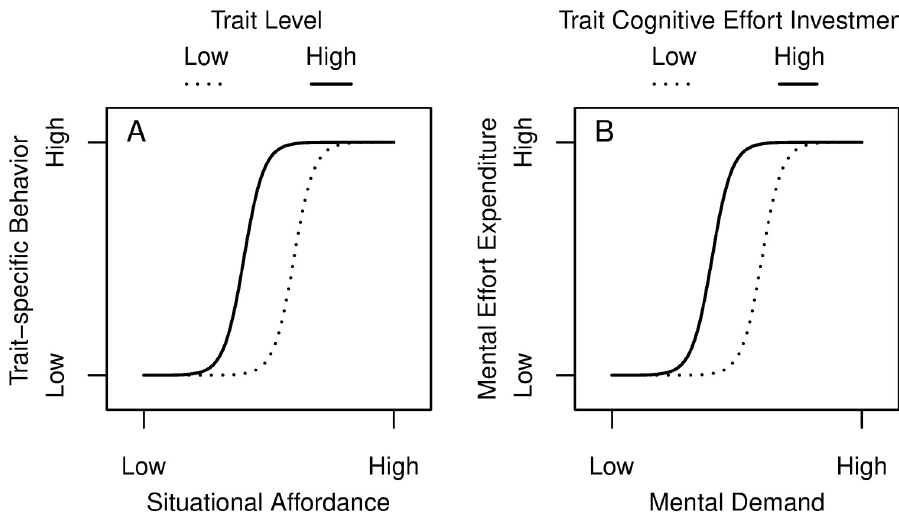
Fig 3. Nonlinear interaction of person and situation. (A) hypothetical interaction effect between situational affordance and trait levels on the intensity of trait specific behavior in general; (B) hypothetical interaction effect between the mental demand and trait Cognitive Effort Investment on the intensity of the expenditure of mental